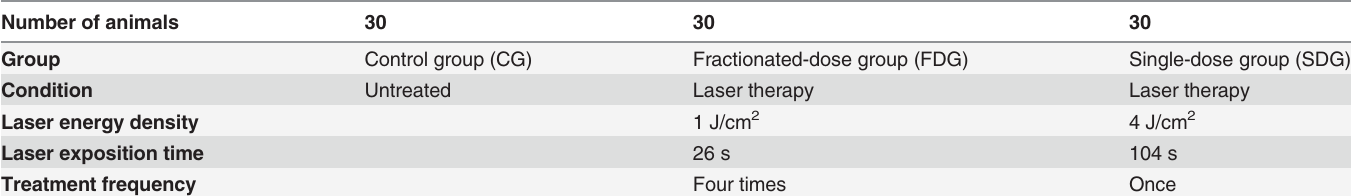
Table 1. Experimental groups and treatment